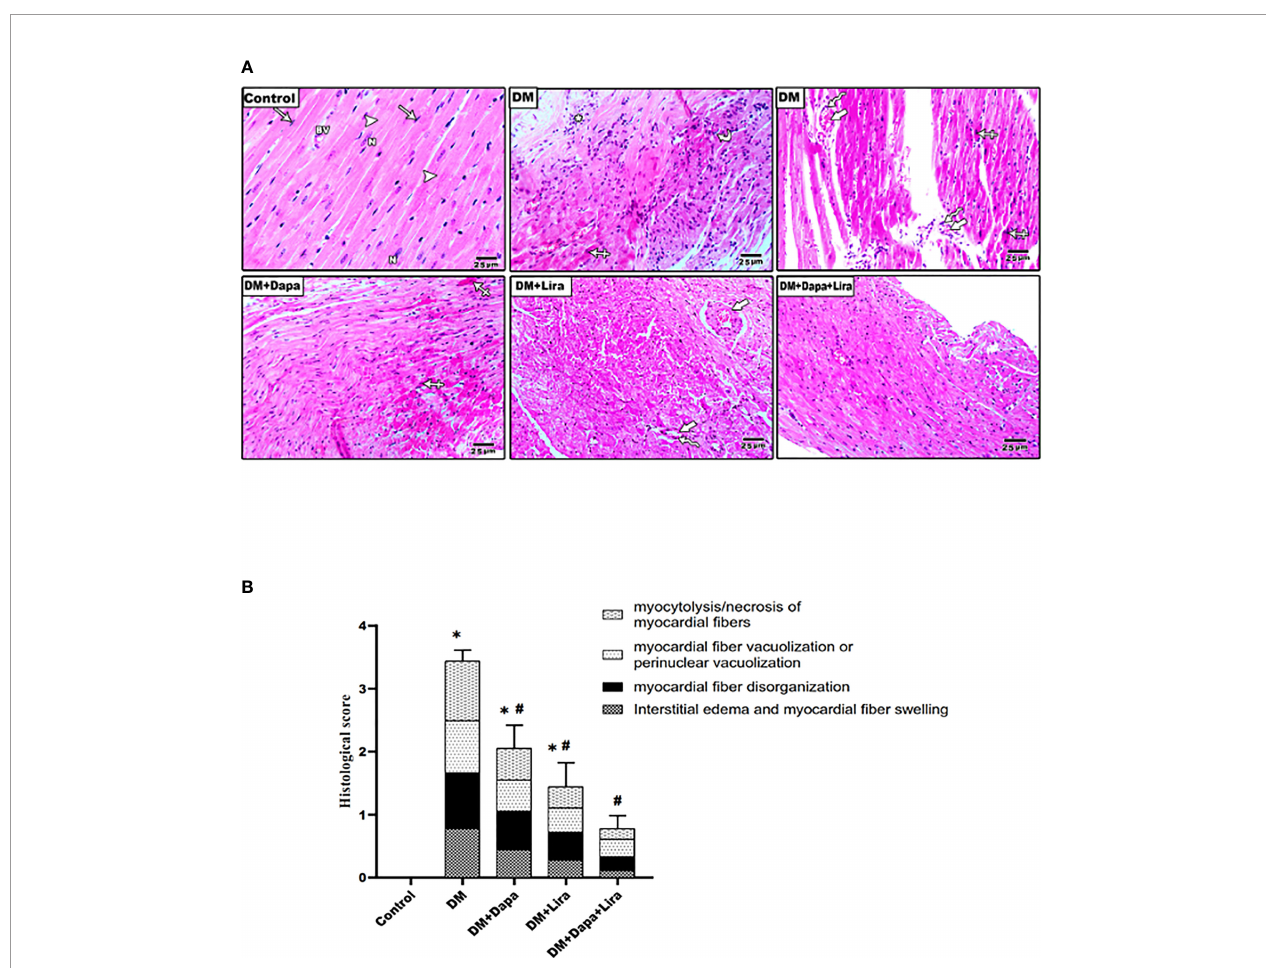
FIGURE 2 | (A) Representative photomicrographs of H&E-stained cardiac sections from different experimental groups. Normal control rats showed normal histological structure of the cardiac muscle diabetic group demonstrating disarray of the cardiac myocytes with myocardial fi ber disorganization (curved arrow), myocardial fi ber necrosis with chronic in fl ammatory cells in the subpericardium (astrix), apoptotic myocyte with hypereosinophilic cytoplasm, pyknotic nuclei (crossed arrow), increased intermyocyte (thick arrows), and perivascular chronic in fl ammatory cells (zigzag arrows) marked interstitial edema. Treatment groups (DM+Dapa) and (DM+Lira) showed less structural injury. Combination therapy group (DM+Dapa+Lira) showed almost restoration of normal cardiac structure. ×400 bar 25. (B) A graph showing histological score for cardiomyopathy. Data are expressed as mean ± SEM (n = 6). * p < 0.05 versus control and # p < 0.05 versus diabetic group. Dapa, dapagli fl ozin; Lira,